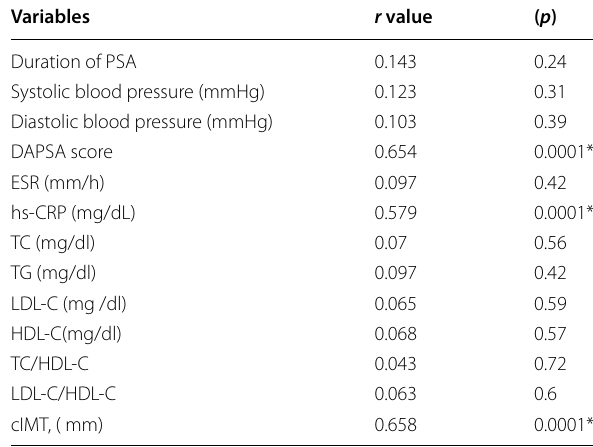
Table 3 Comparison between active patients with patients in remission or mild activity